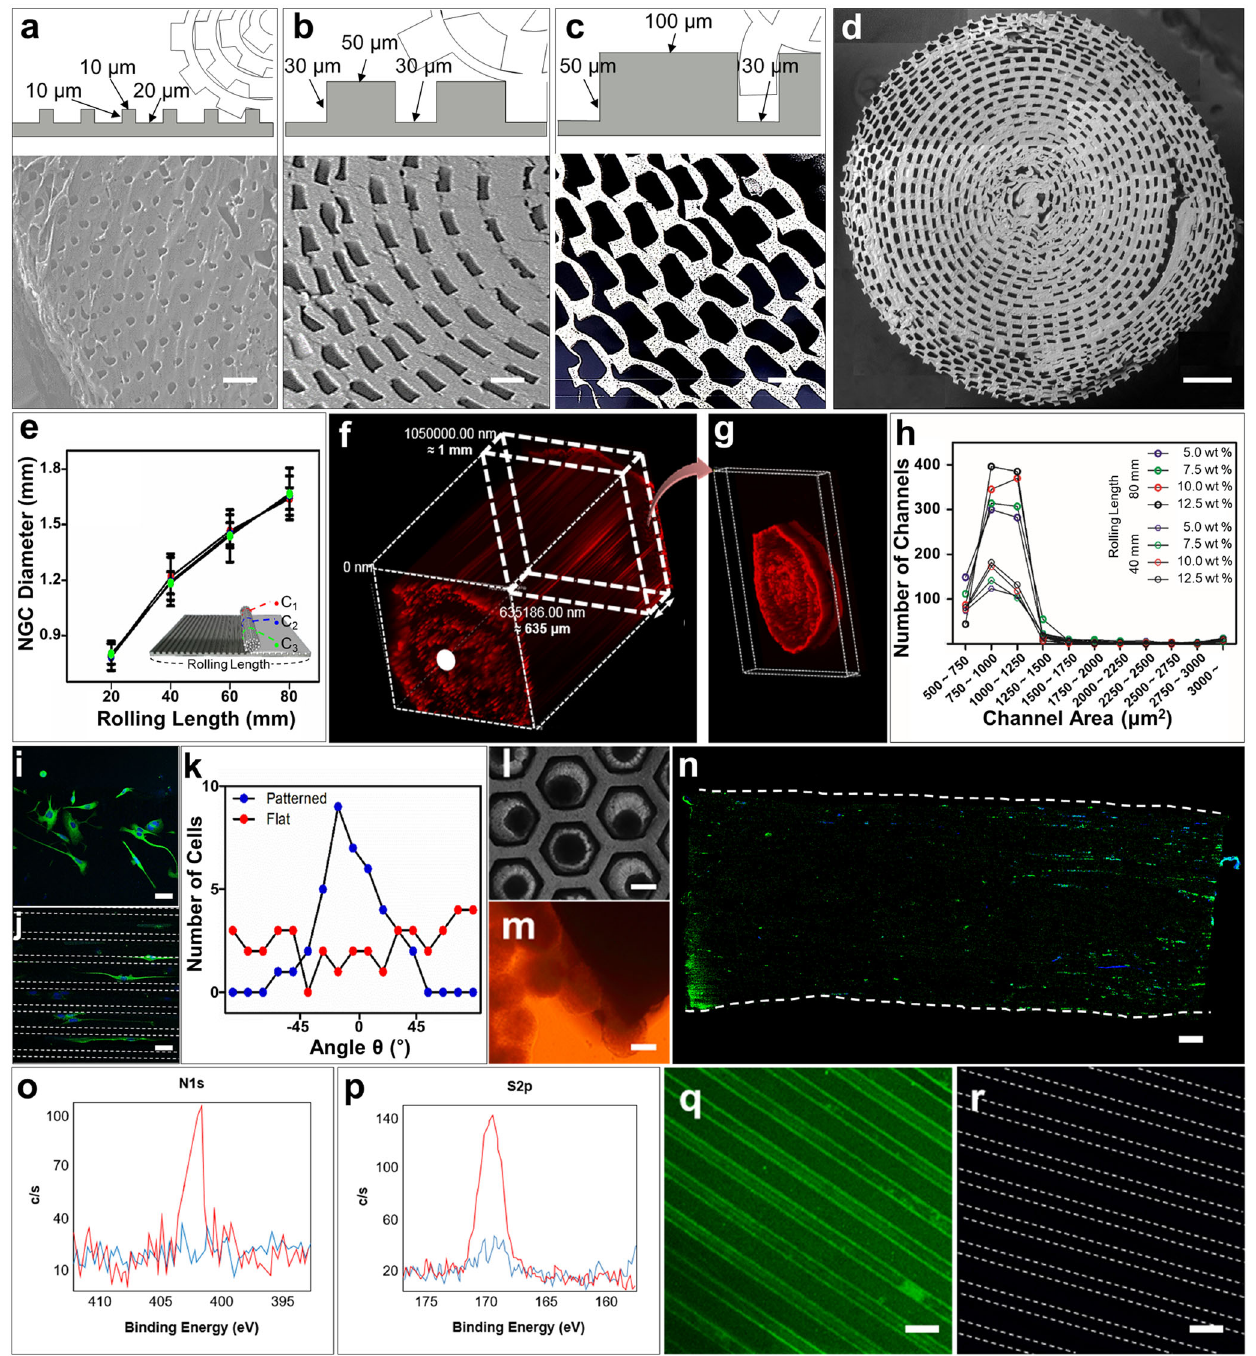
Fig. 2 Size-tunability of the produced NGC and prototype selection. a – c Schematic diagrams (top) and SEM images (bottom) of various NGC micropatterns with dimensions (ridge width × ridge height × groove width ( μ m)) of a 10 × 10 × 20, b 50 × 30 × 30, and c 100 × 50 × 30. d SEM image of the s-section of NGC with a diameter 1.6 mm. e NGC diameter along with the rolling length ( n = 3). Values are presented as mean ± SD. f , g Fluorescence images of the microchannels of the NGCs fi lled with red fl uorescent polystyrene beads. h Channel-area distribution in mNGCs produced with different rolling distances (40 and 80 mm) and different concentrations PLCL solution (5.0, 7.5, 10.0, and 12.5%). i , j Fluorescence images of the PC12 cells cultured on i fl at and j unrolled PLCL-patterned sheets. k The number of cells with a certain alignment angle between the micropattern and neurite. l , m Optical images of PC12 cell spheroids l formed on the concave mold and m cultured close to the NGC planes. n Fluorescence image of neurite growth from spheroids into mNGC. o , p XPS intensity measured for detection of SP on PLCL-SP. q , r Immunostaining SP on the unrolled PLCL-patterned sheet: q presence of SP and r absence of SP. Scale bars are as follows. a – c 50 μ m, d 250 μ m, i , j 50 μ m, l – n 250 μ m, and q , r 50 μ m. Green fl uorescence represents β -III tubulin antibodies in ( i ), ( j ), and ( n ), and SP antibodies in ( q ) and ( r